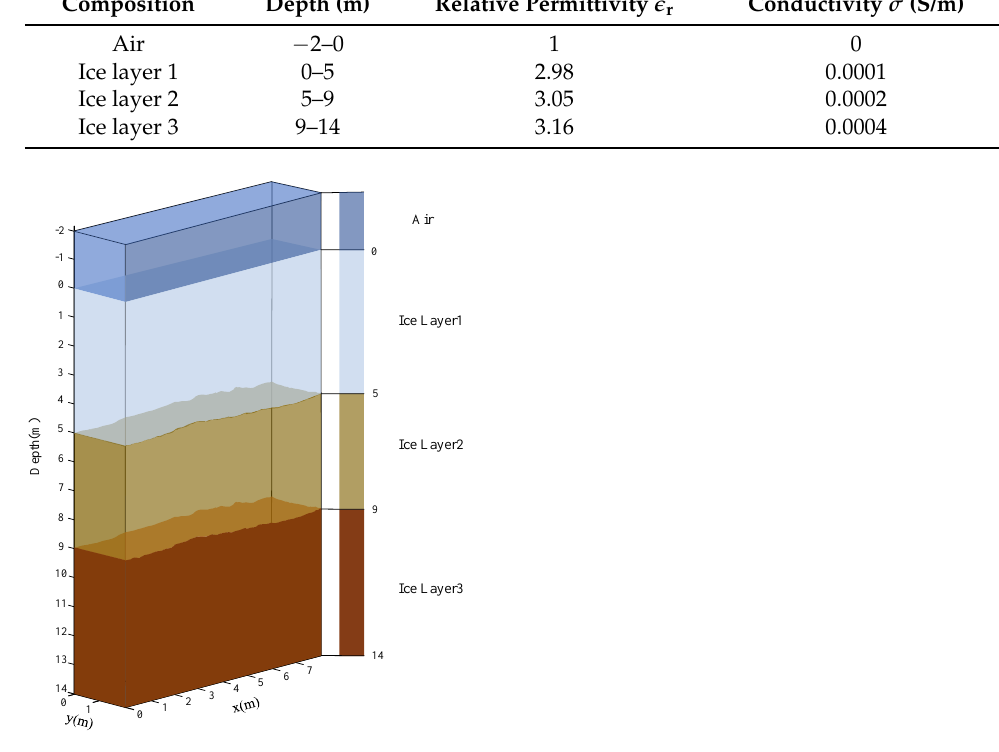
Figure 8. The 3D ice structure model. The center frequency of the simulated antenna is set to 500 MHz. The distance between the transmitting and receiving antennas is 0.1 m, and the antenna is located 0.3 m above the interface between the air and the glacier. The offset of the antenna is 0.04 m. The sampling frequency is 2.6 GHz. The time window of acquisition is 160 ns, and 150 channels of data are collected. Since the pseudo-random coded radar we used can collect data in HH polarization and HV polarization modes, the simulation experiment also collected data in two polarization modes. After preprocessing, such as direct wave removal, zero-point correction, and gain, the simulated glacier profiles collected in HH and HV polarization modes are shown in Figure 9. The 75th track of the two profiles is shown in Figure 10.